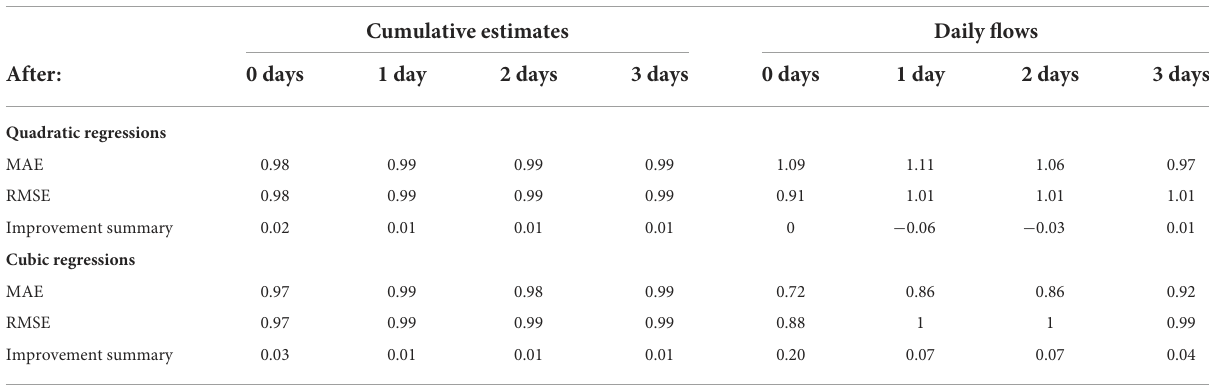
TABLE 1 Measures of accuracy for corrected mortality estimates on 18 January to 26 February 2021. Panel A. Data for